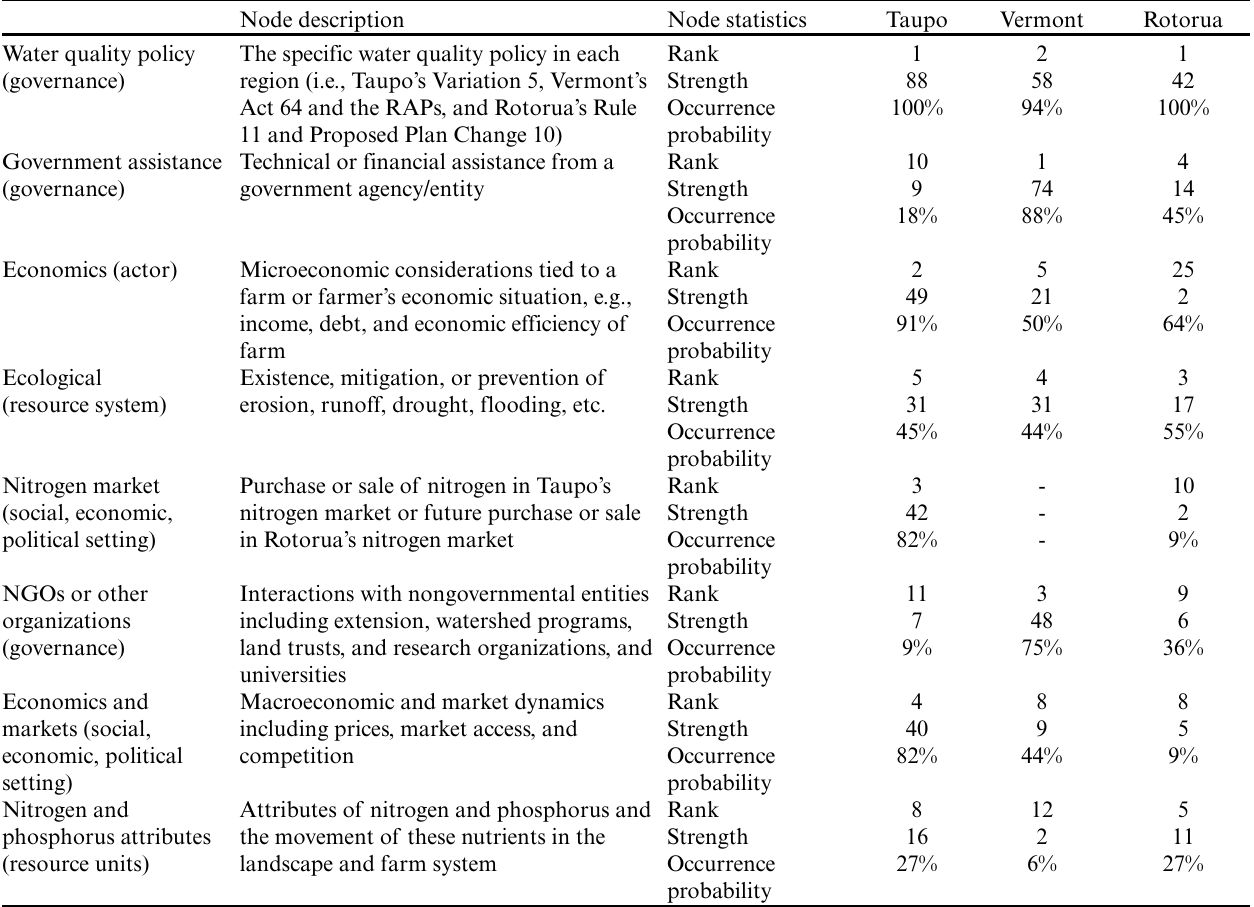
Table 5 . Key behavioral driver node statistics. Key drivers are those that are ranked by strength in the top five of drivers in at least one of the three regions. Lack of statistics for a node in a region means that a node was not mentioned in the region.